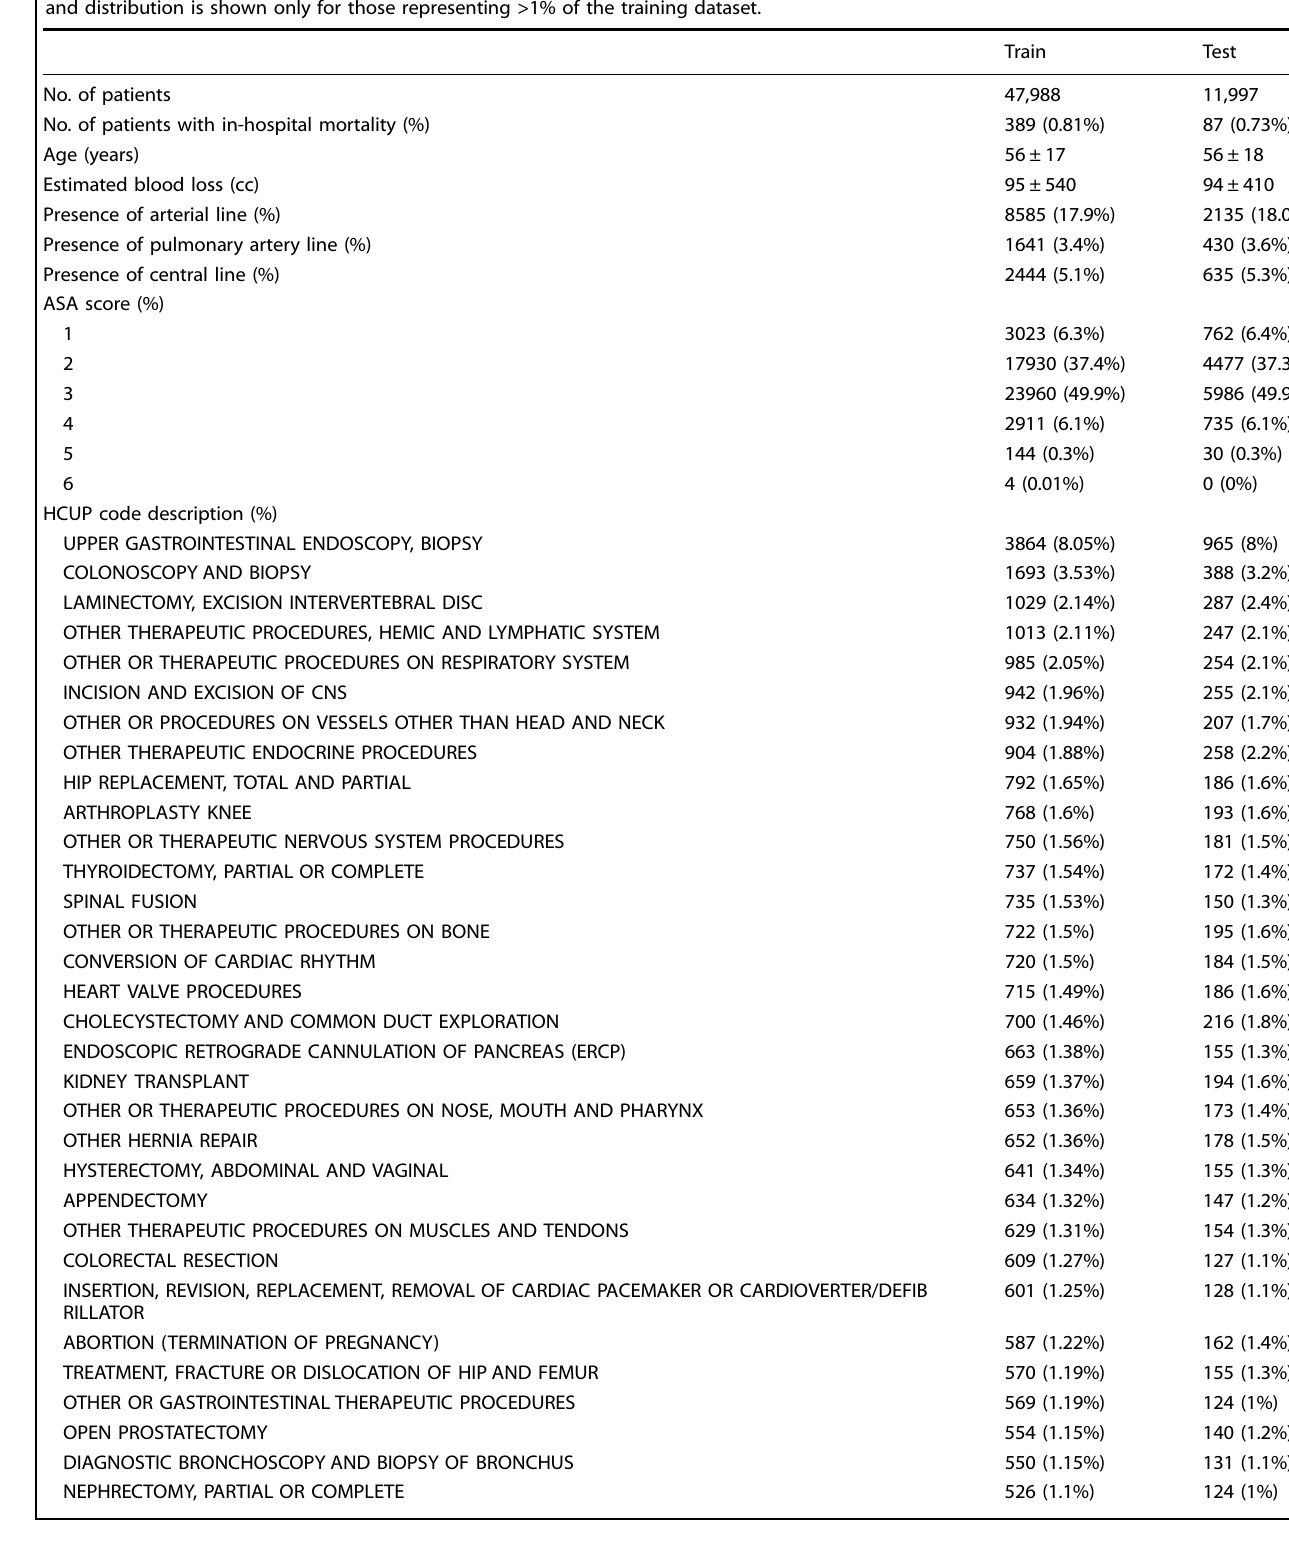
Table 1. Training and testing dataset patient characteristics reported as number patients (%) or mean ± standard deviation. HCUP code description and distribution is shown only for those representing >1% of the training